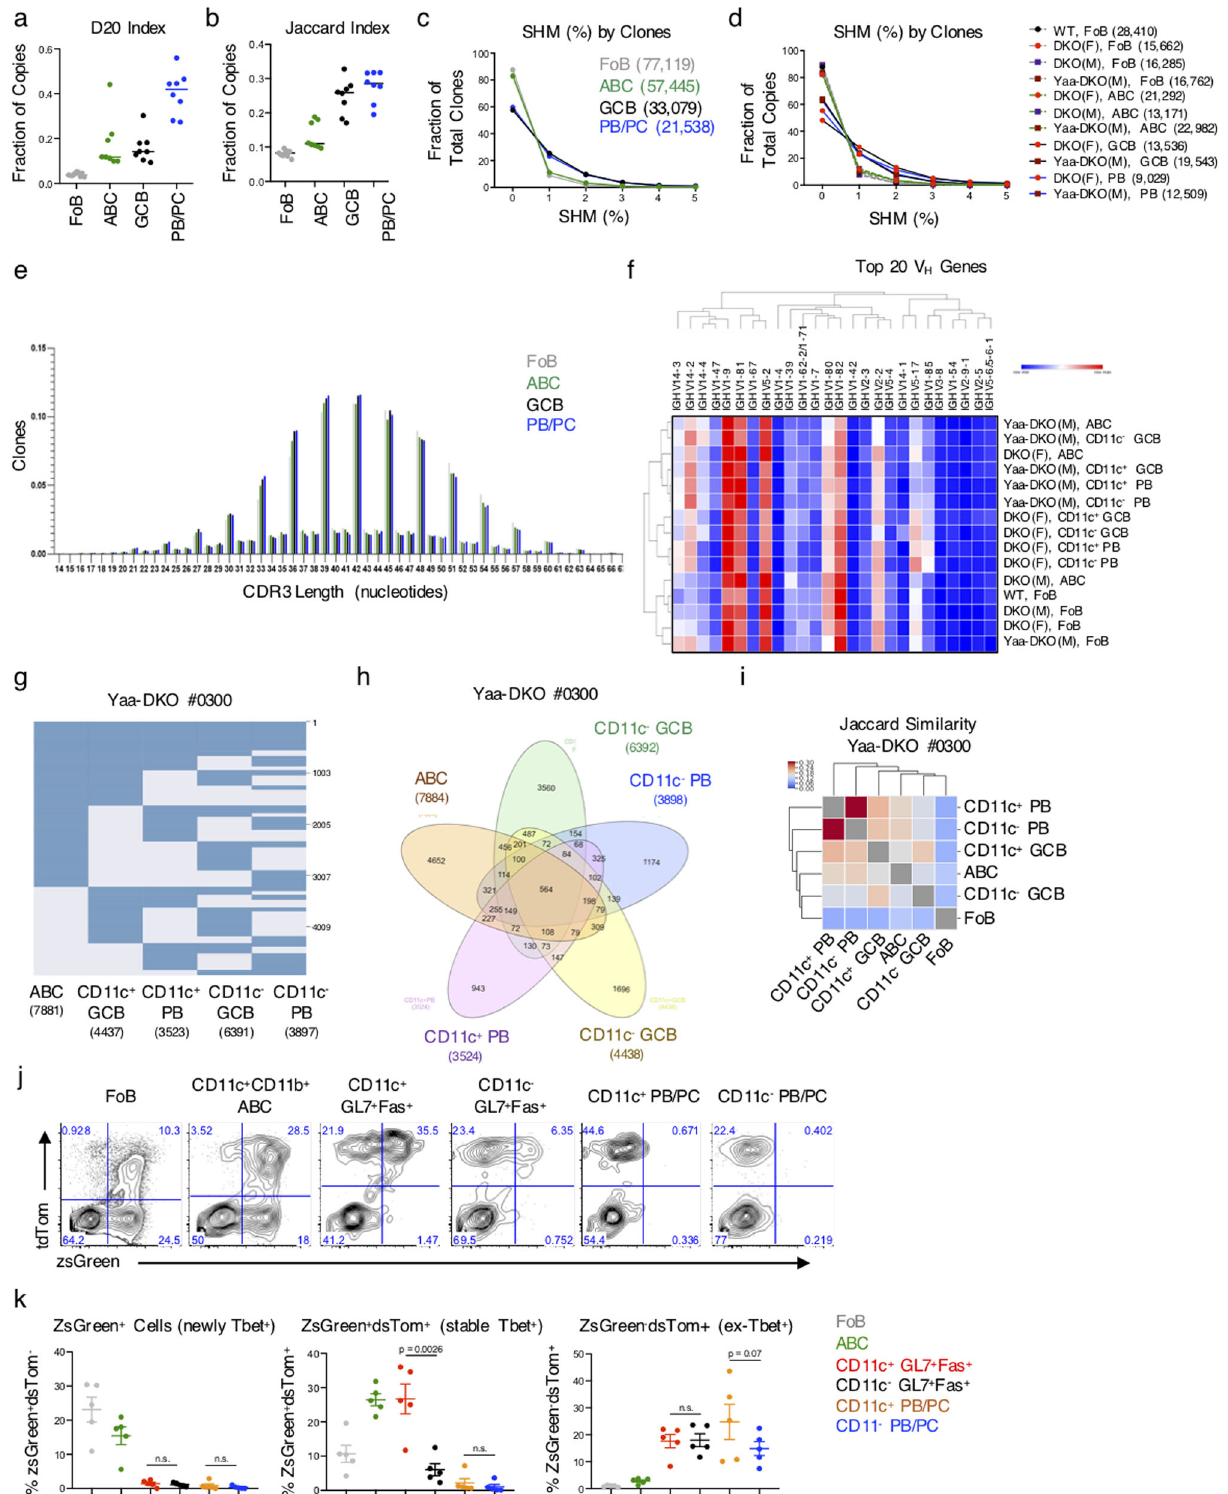
relationships with both CD11c + and CD11c − GC B cell and PB/PC populations. Enrichment for an ISG signature differentiates ABCs from DKO females and males . While ABCs from female and male DKOs exhibited similar BCR repertoire features, their marked